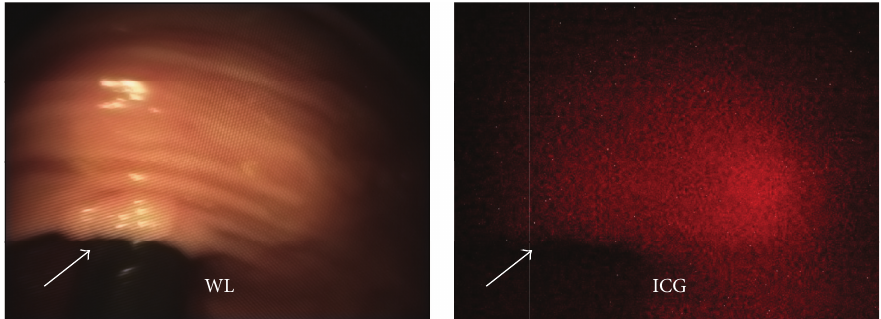
Figure 4: Patient 2 fluorescence endoscopy. A tubular adenoma is indistinguishable from adjacent normal colonic mucosa on ICG imaging, representing a false